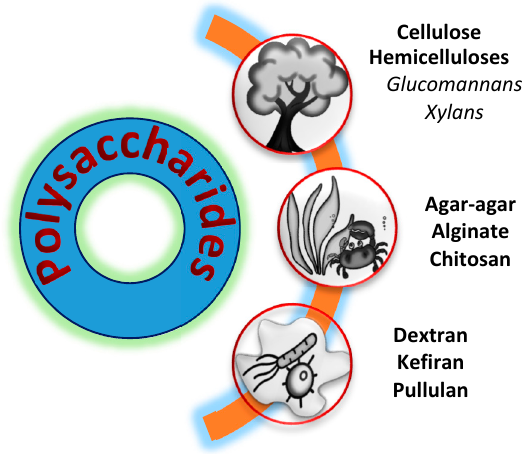
Figure 1. Examples of bio-based polysaccharides (from plant, marine organisms and microbial) as materials for food packaging.